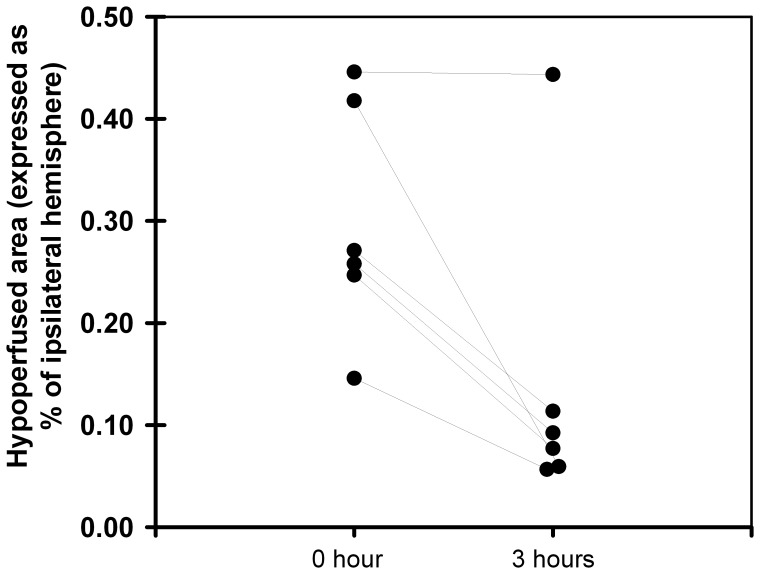
Evolution of hypoperfusion areas (expressed as % of ipsilateral hemisphere) between 0 and 3 hours in Experiment 2 (n = 6).CBF maps were thresholded at the 10th percentile value of perfusion in the contralateral hemisphere.